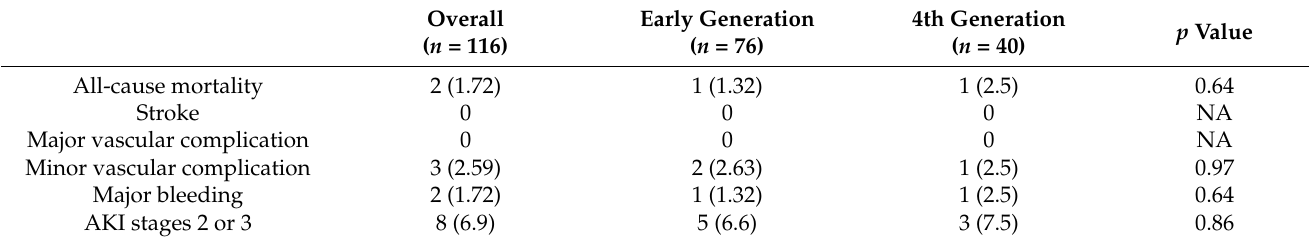
Table 5. In-hospital outcomes for the whole cohort and according to the device generation